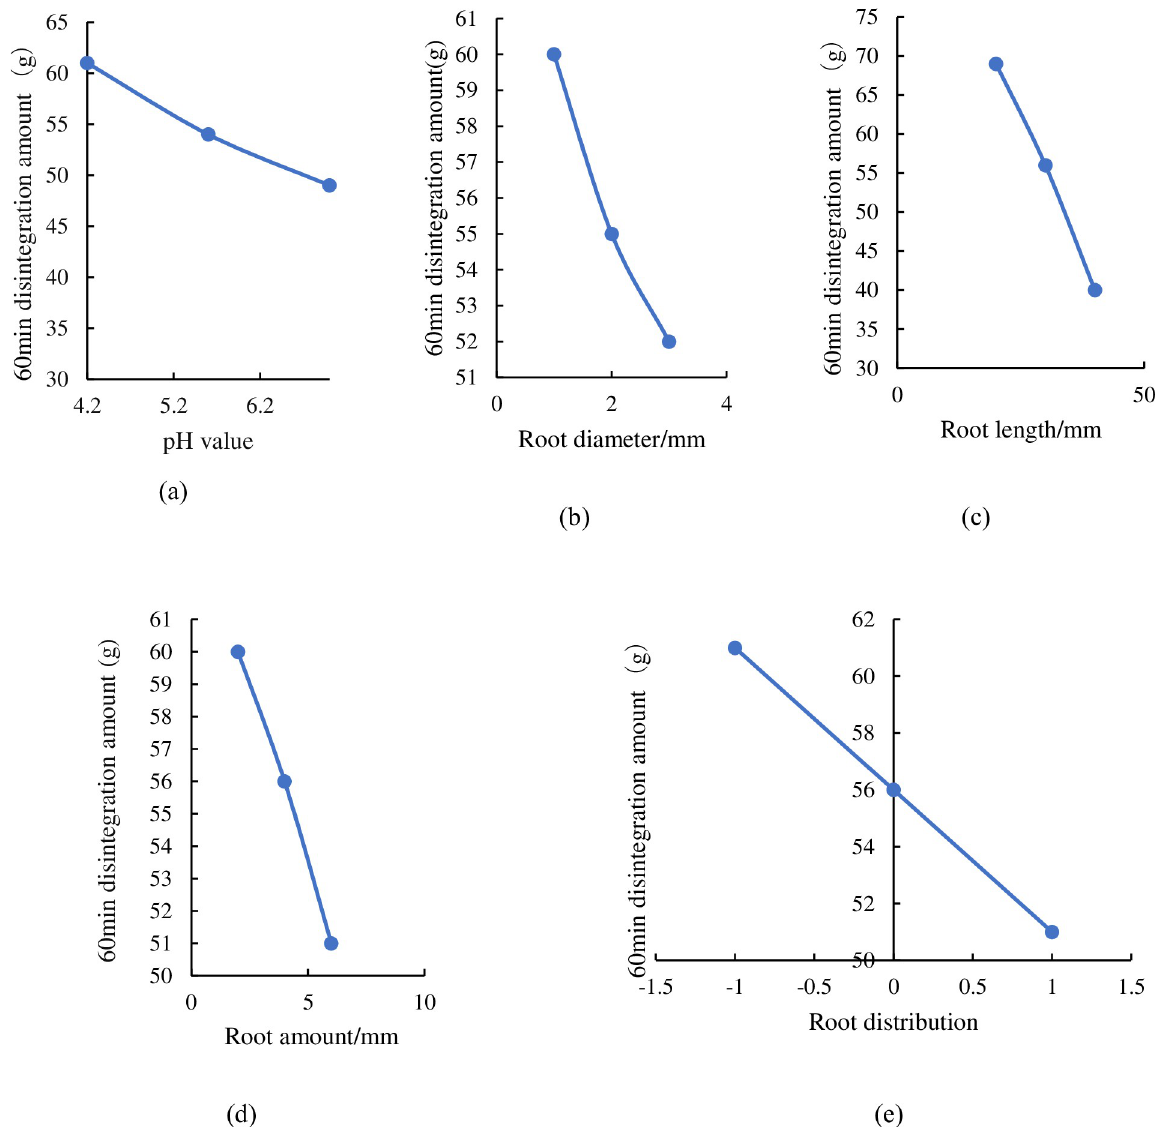
Fig 2. Single-factor analysis curve of 60min disintegration regression